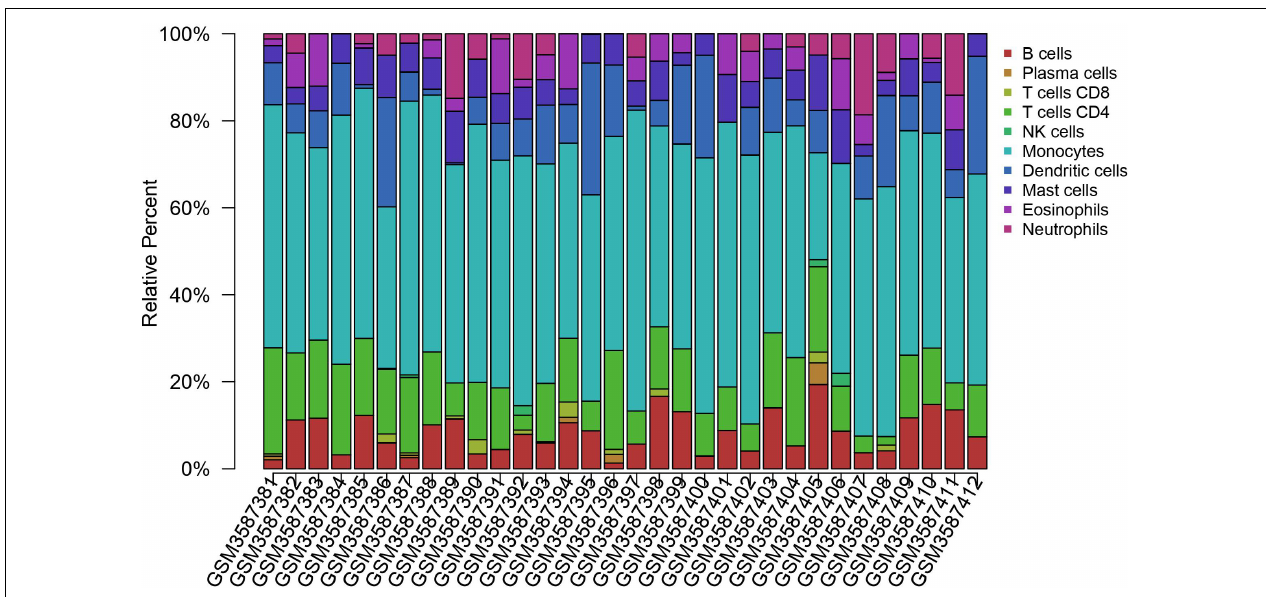
FIGURE 2 | Immune cell infiltration of primary breast cancer and brain metastasis breast cancer. Immune cell infiltration analysis of primary breast cancer and brain metastasis breast cancer using CIBERSORTx. The primary breast cancer samples range from GSM3587381 to GSM3587396; the others are brain metastasis samples. Raw data are downloaded from the GEO database. Data set: GSE125989, https://www.ncbi.nlm.nih.gov/geo/query/acc.cgi?acc=GSE125989. The difference between the primary tumor site and brain metastasis tumor is not statistically significant. More subgroups should be analyzed for a better understanding